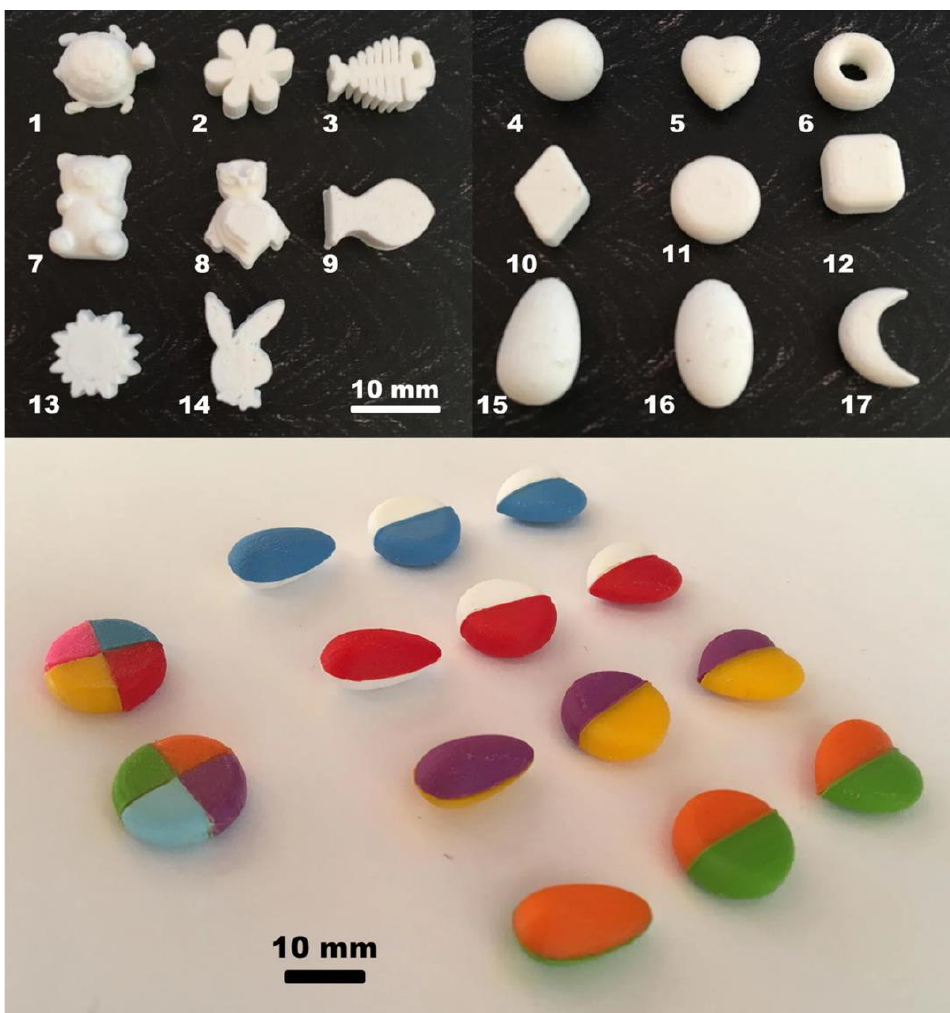
Figure 2. 3D-printed solid dosage forms in various shapes ( upper part ) and 3D-printed polypills ( lower part ) [33].